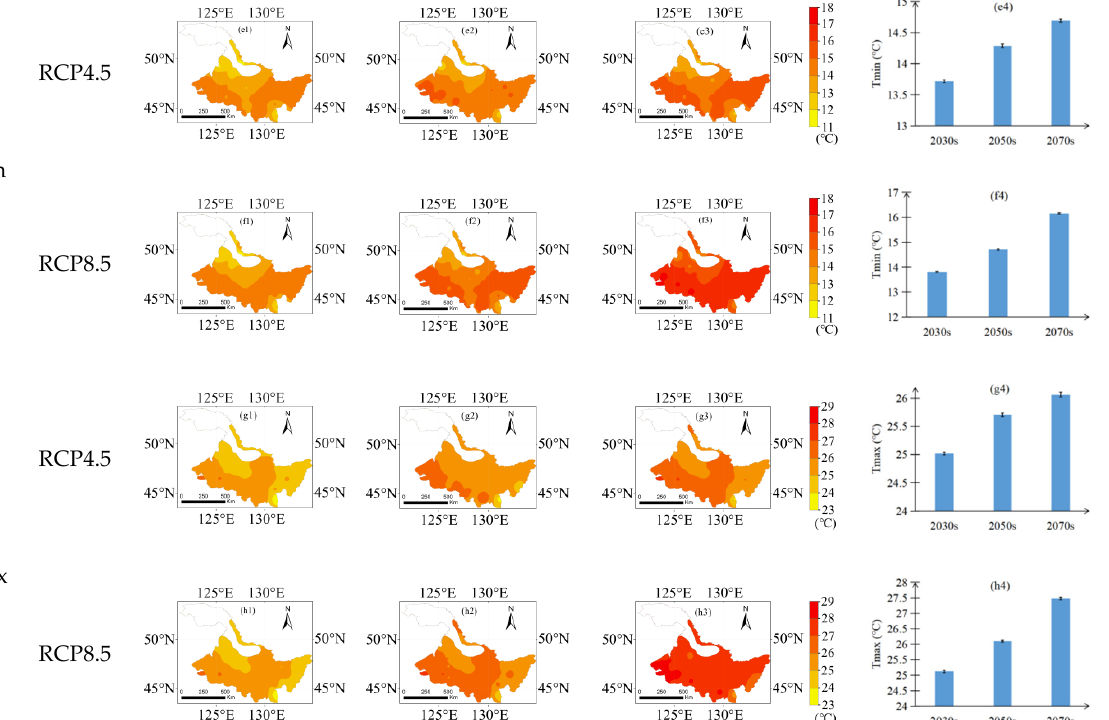
Figure 6. Spatial and temporal distribution of average precipitation ( Pe ) ( a1 – a4 , b1 – b4 ), solar radiation ( Rad ) ( c1 – c4 , d1 – d4 ), minimum temperature ( Tmin ) ( e1 – e4 , f1 – f4 ), and maximum temperature ( Tmax ) ( g1 – g4 , h1 – h4 ) for the multi-GCM ensemble during the maize growth stage under two RCPs from 2021–2080 in the study area.